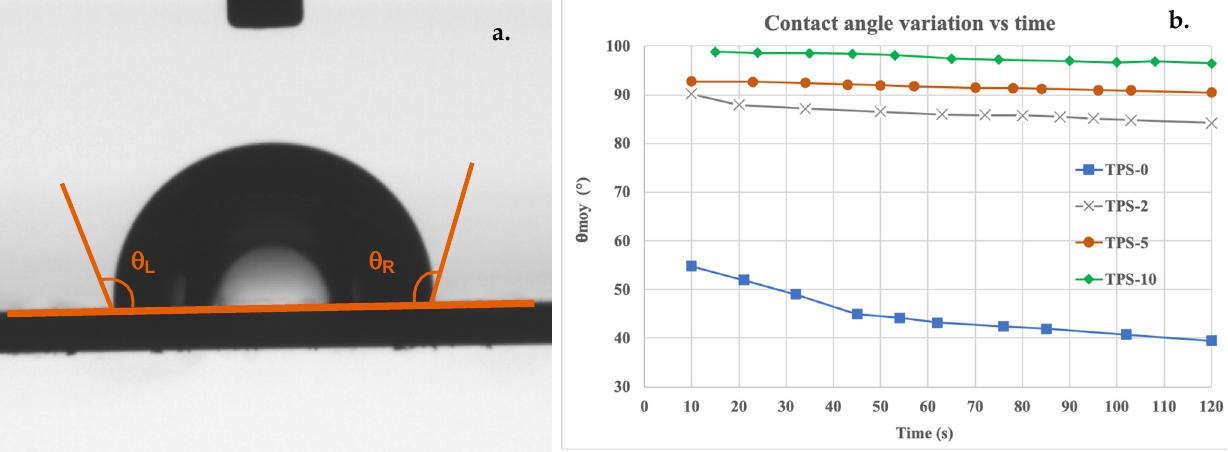
Figure 6. Surface contact angle picture for TPS-10 ( a ) and kinetic of water sorption according to FASE ratio in TPS/FASE-ratio ( b ).